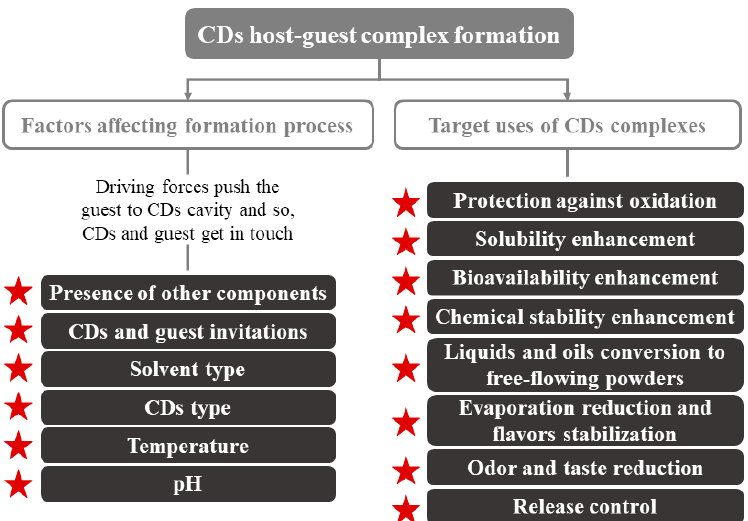
Figure 2. Factors affecting CDs inclusion complex formation and main application of CDs. Adapted from